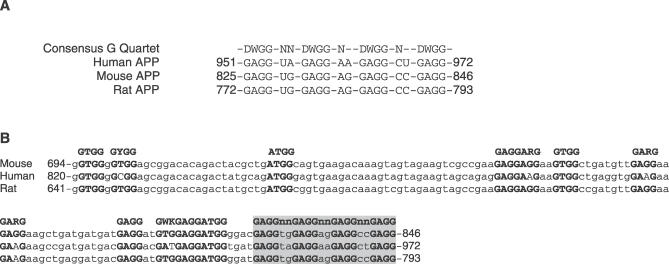
The Coding Region of APP mRNA Contains a Putative G-Quartet Sequence within a G-Rich Region Containing Several DWGG Repeats(A) Alignment of the canonical G-quartet motif with the putative G-quartet sequence in human, mouse, and rat APP mRNAs.(B) Alignment of the G-rich region of the human, mouse, and rat APP genes. The predicted G-quartet sequence is located at position 825–846 of the mouse gene and is highlighted.